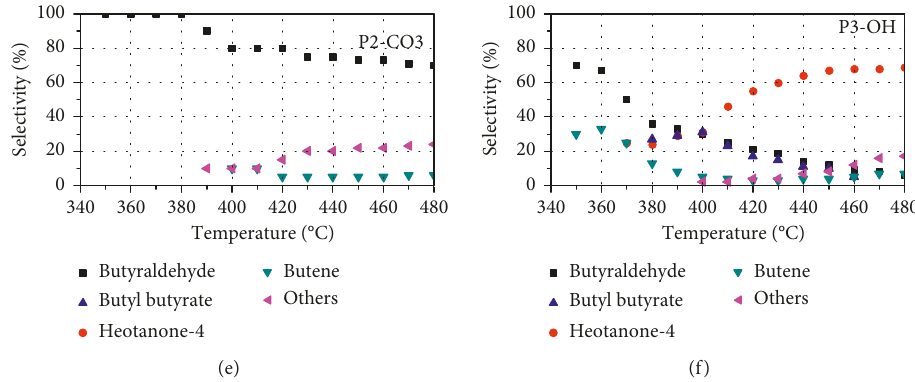
Figure 9: The dependence of the yield and selectivity of butan-1-ol conversion on temperature for the ferrite catalysts. (a) P1-C2O4. (b) P1- C2O4. (c) P2-CO3. (d) P2-CO3. (e) P3-OH. (f) P3-OH.